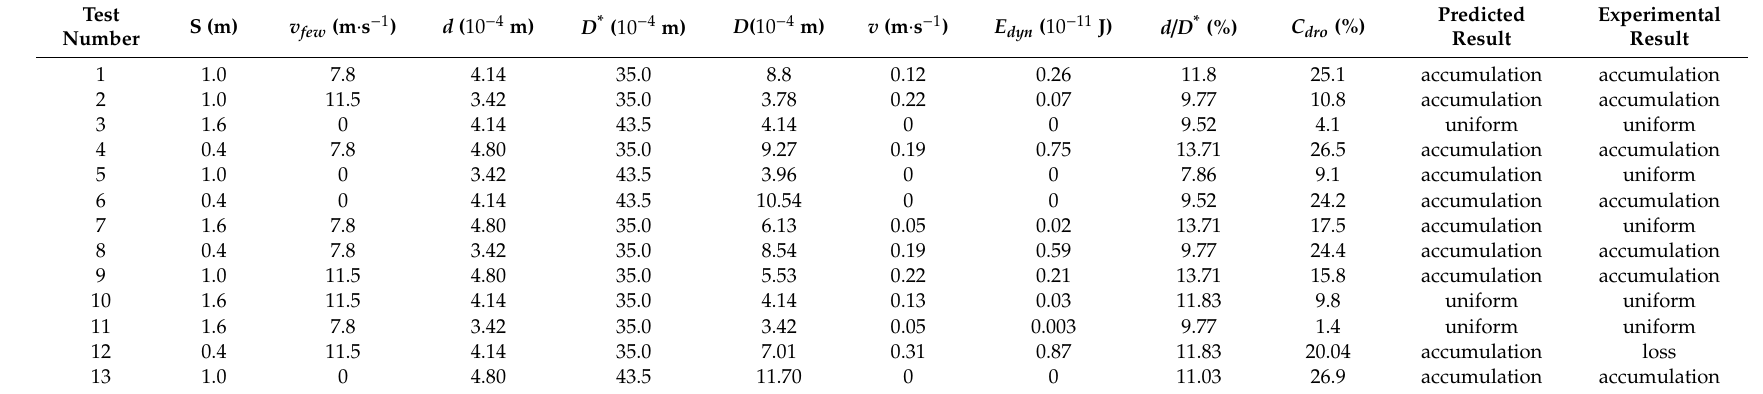
Table 1. Predicted and actual states of deposition of droplets on the obverse of Litchi leaves under di ff erent combinations of operating parameters.